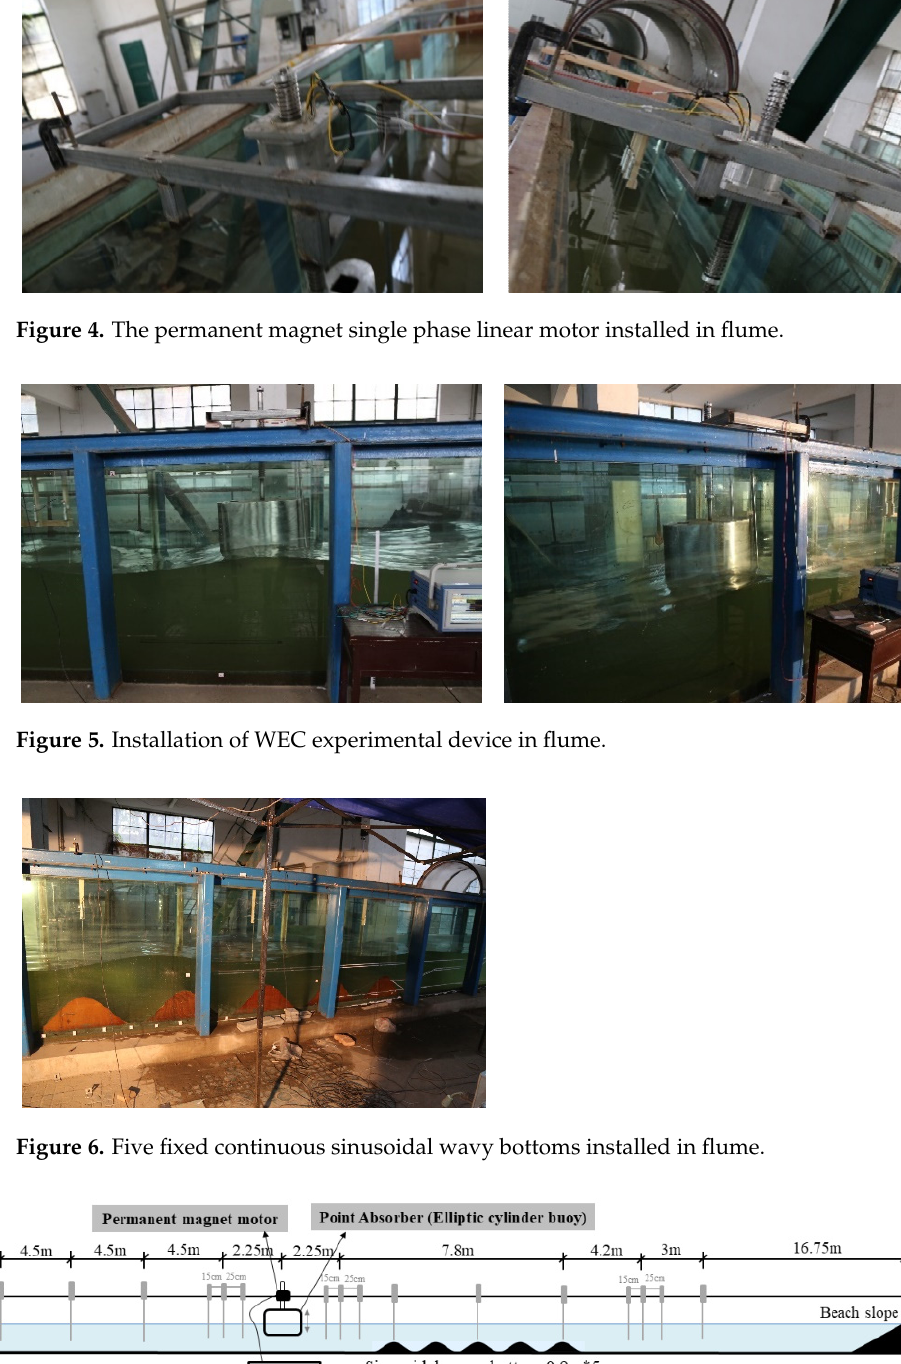
Figure 4. The permanent magnet single phase linear motor installed in flume.